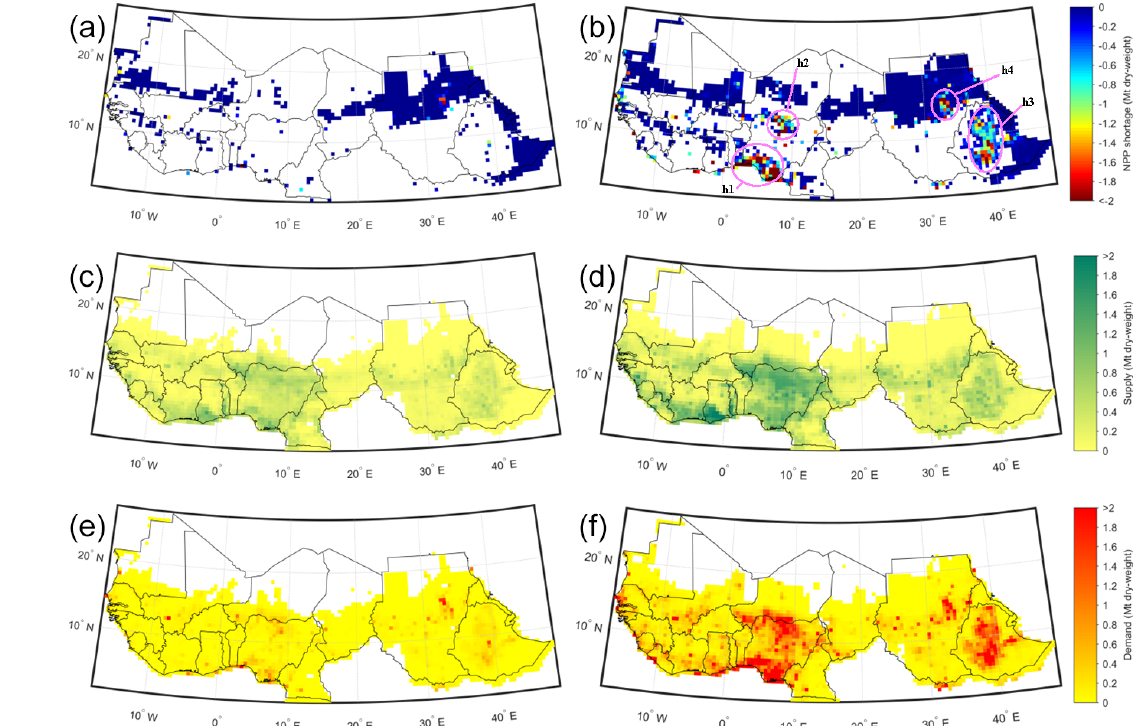
Figure 4. Maps of NPP shortage (a, b) , NPP supply (c, d) , and NPP demand (e, f) for the year 2000 (a, c, e,) and SSP2–RCP6.0 year 2050 (b, d, f) . The hotspots of large NPP shortage are marked with circles in panel (b) , where h1 is in the area around Lagos (Nigeria) and the Niger delta; h2 is in the Nigerian hinterlands (close to Kano); h3 is in the Ethiopian highlands (close to Addis Ababa); and h4 is in the area surrounding Khartoum (Sudan). In panel (a) we excluded all areas with a surplus in the NPP balance.